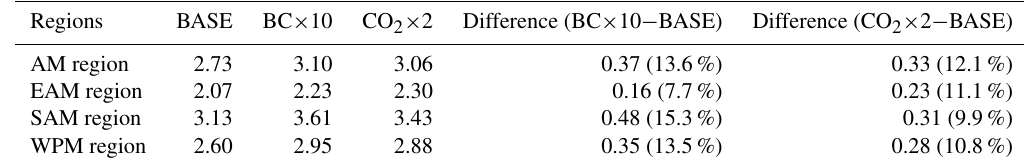
Table 1. Multimodel mean of the MJJAS precipitation minus evaporation ( P − E ; unit: mmd − 1 ) in the Asian monsoon region (AM) and the subregions, including the East Asian monsoon (EAM), the South Asian monsoon (SAM) and the western North Pacific monsoon (WPM) for BASE, BC × 10 and CO 2 × 2 experiments as well as corresponding differences between BC × 10 (or CO 2 × 2) and the BASE